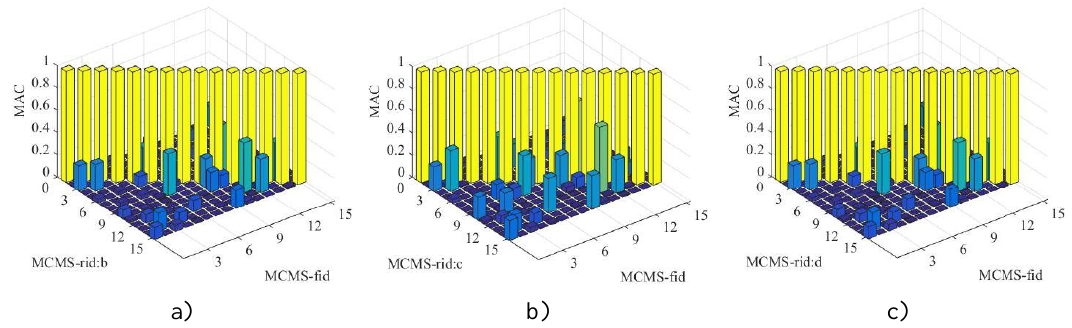
Figure 6. Modal assurance criterion between the modes by the MCMS-fid method and MCMS-rid method different interpolation schemes. ( a ) MCMS-rid:b vs. MCMS-fid; ( b ) MCMS-rid:c vs. MCMS-fid; ( c ) MCMS-rid:d vs.